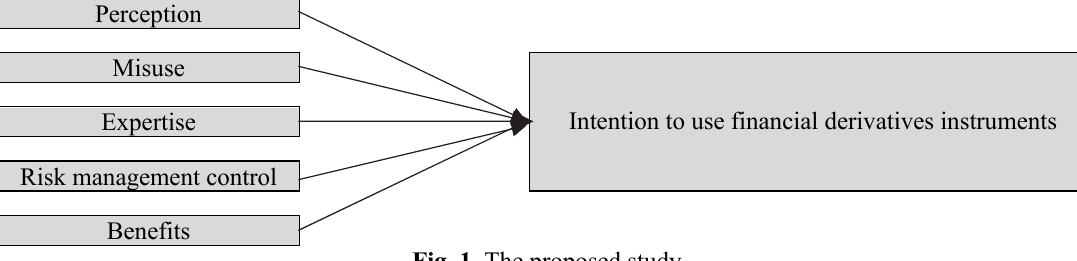
Fig. 1. The proposed